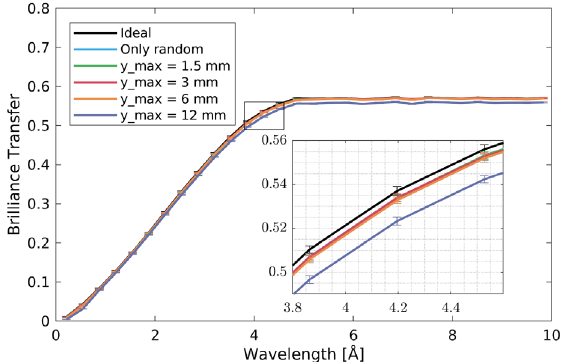
FIG. 6. Brilliance transfer as a function of wavelength for a straight guide under displacement model 2.